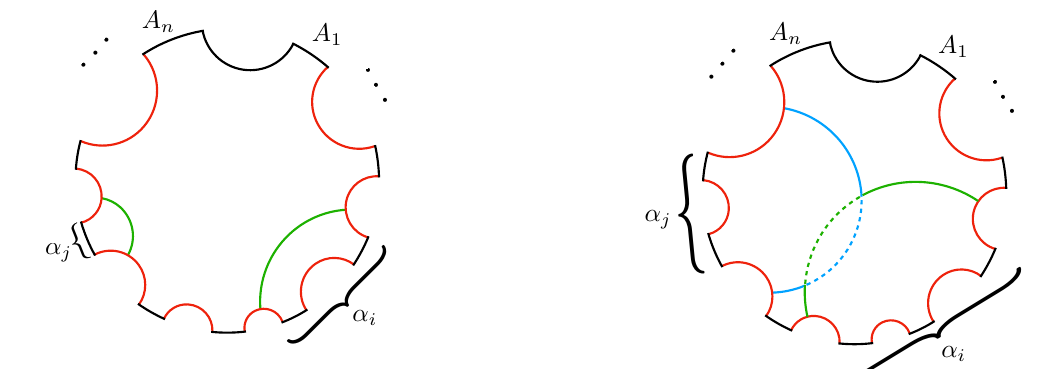
Figure 7 . [Left] An example of segments of the surface corresponding to E W ( α 1 : · · · : α m ) on a single tile that subtend the collections of boundary subregions α i and α j , with i < j . [Right] An inconsistent configuration; the blue and green segments cannot both be minimal if the dashed parts have different length. If they have exactly the same length, then we can redefine one of the segments by letting it run along the other’s dashed